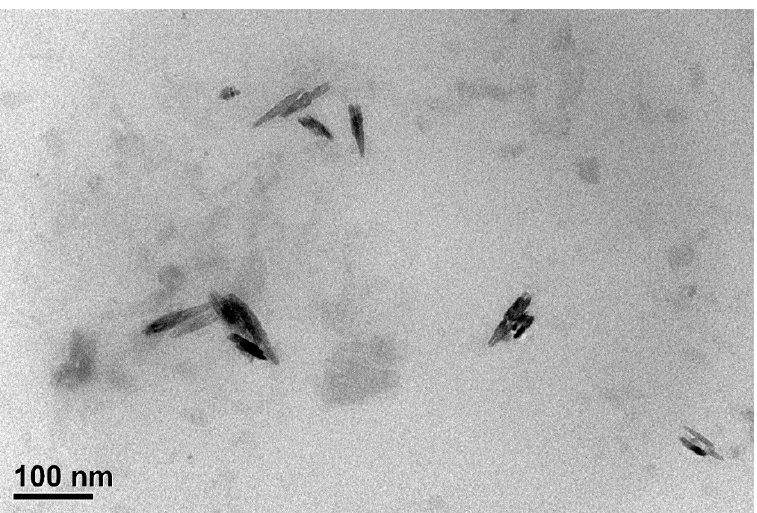
Figure 4. TEM image of PBAT/m-PPZn-10.